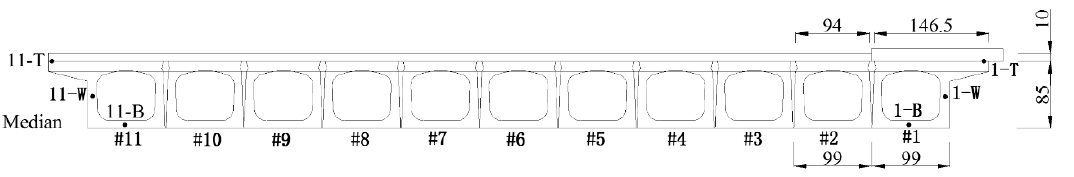
Figure 15. Layout of cross-section of side-by-side box girder (cm).